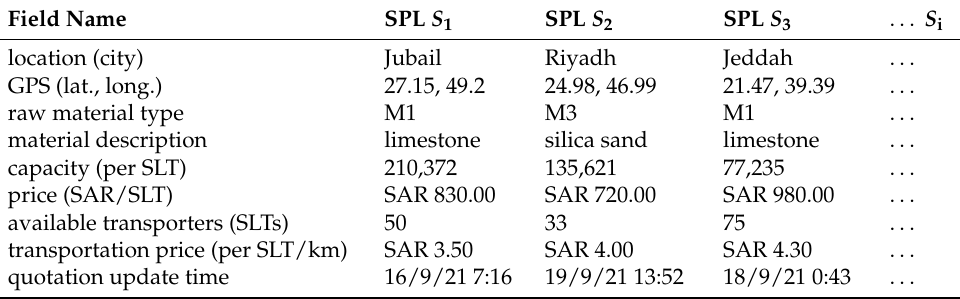
Table 2. An example of dynamic data offered by OD.